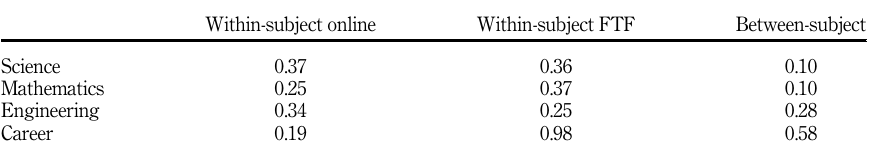
Table 7. Power analysis